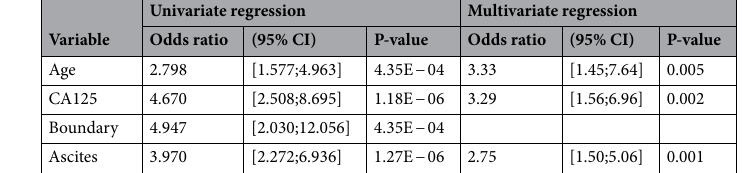
Table 2. Results of univariate and multivariate logistic regression for predicting malignancy in ovarian masses.